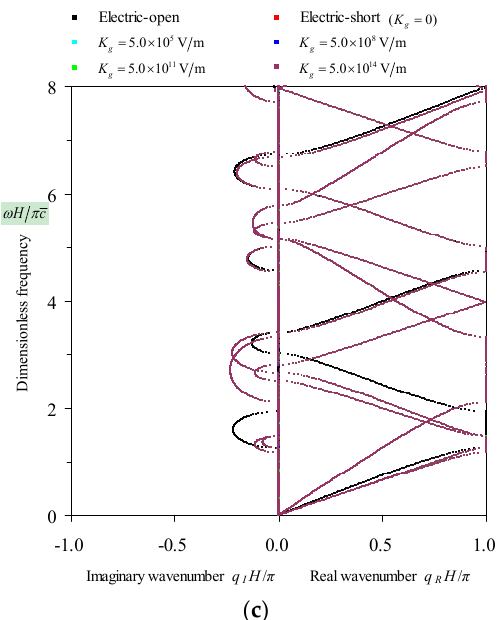
Figure 9. The effects of the electrical boundaries on the wavenumber spectra of elastic waves in periodic Glass-Brass-(PZT-5H 2 )-Brass multilayers: ( a ) Applied positive capacitance; ( b ) Applied negative capacitance; ( c ) Applied feedback control.